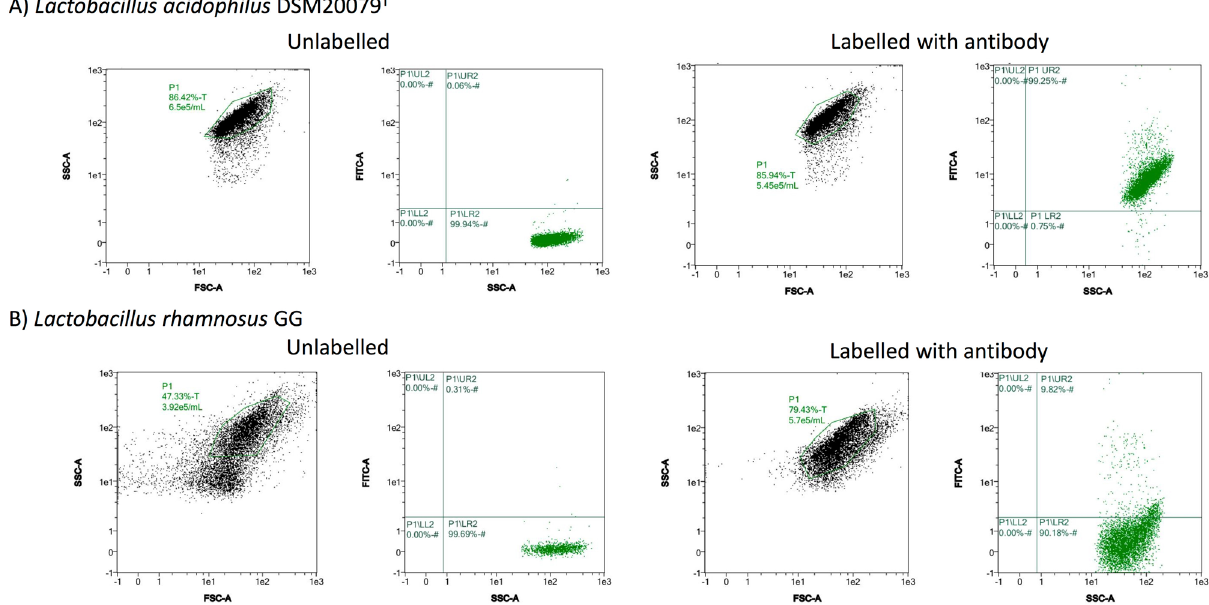
Figure 2. Dispersion diagrams of representative FC experiments showing the acquisition of labelled and non-labelled L. acidophilus DSM20079 T (A) and L. rhamnosus GG (B) cell suspensions in exponential phase of